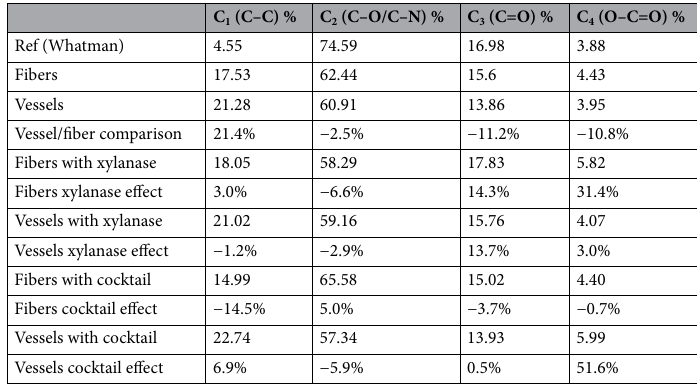
Table 6. Relative amounts of the different carbon chemical surroundings (XPS).